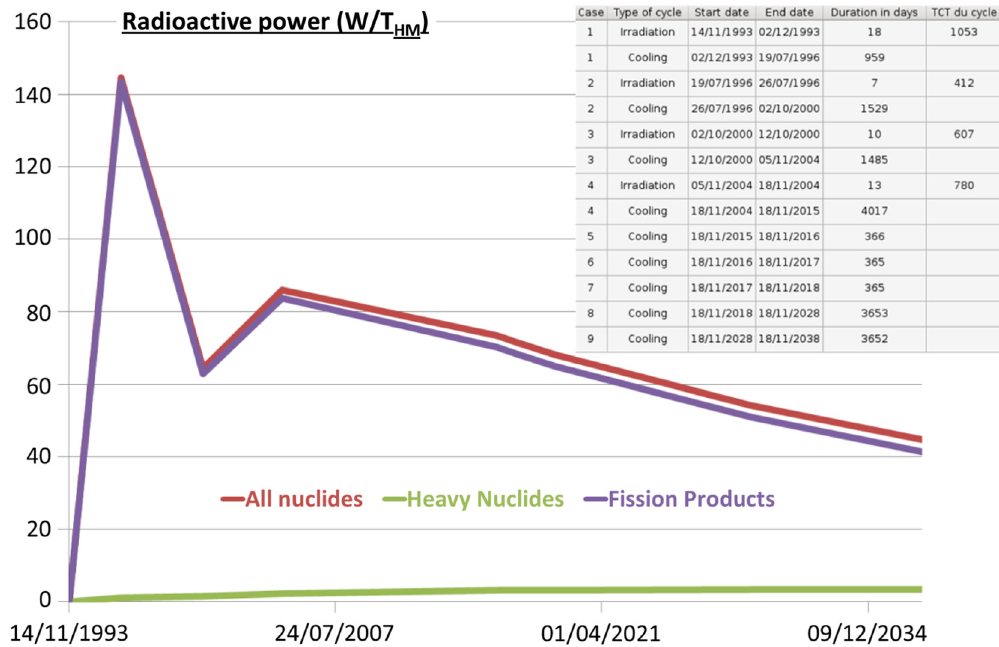
Fig. 7. PHEBUS standard 8 (cid:3) 8 fuel sub-assembly decay heat as a function of